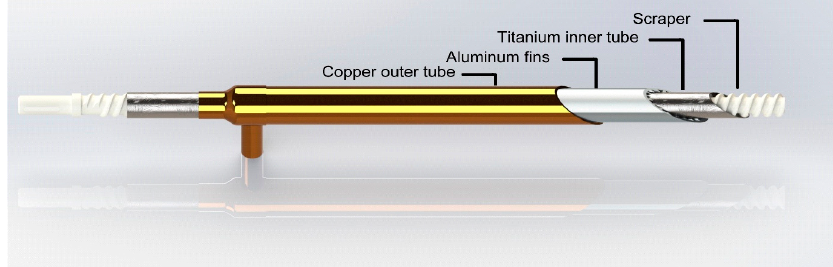
Figure 4. Schematic diagram of the double tube evaporator using scraper.